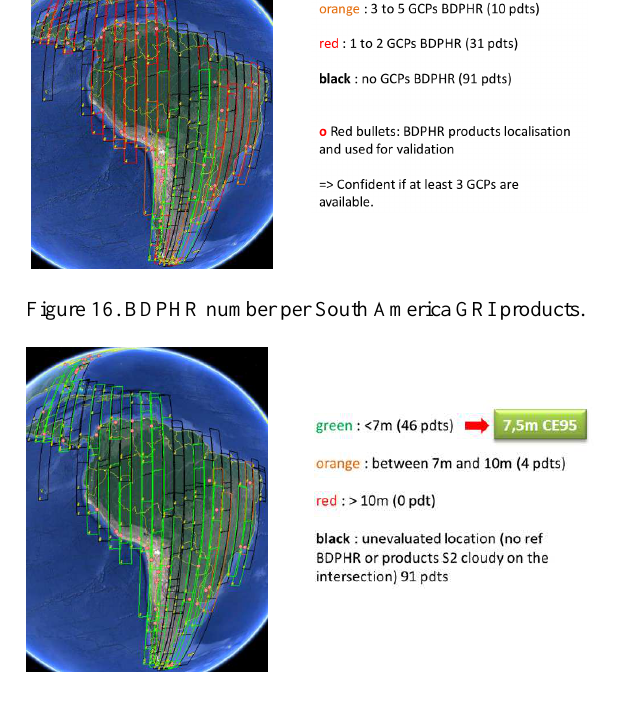
Figure 17. South america GRI mean geolocation